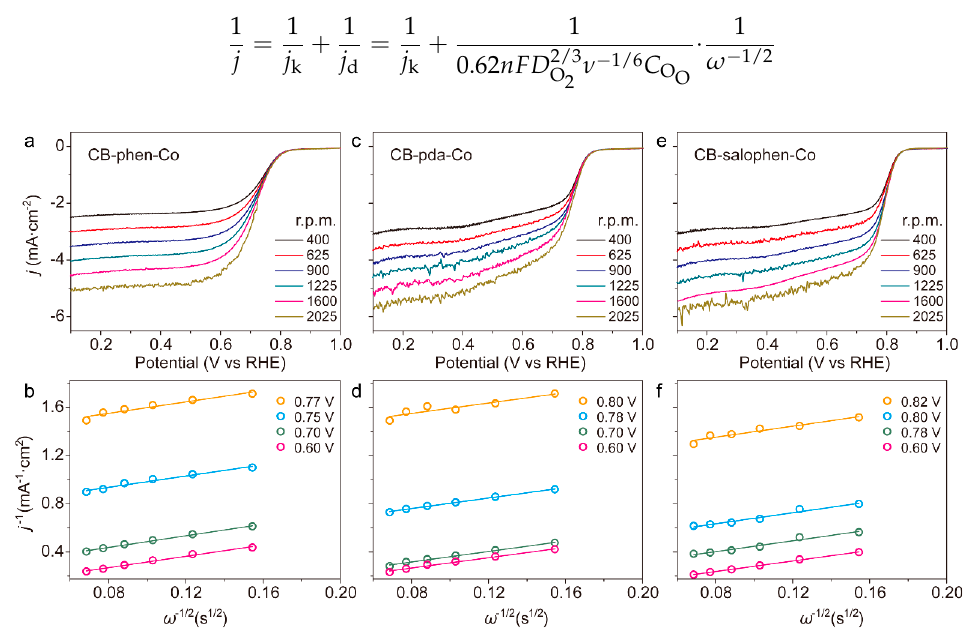
Figure 6. ORR performances of CB-conjugated complexes on RDE. Polarization curves ( a , c , e ) and Koutecky–Levich plots ( b , d , f ) of CB-phen-Co ( a , b ), CB-pda-Co ( c , d ) and CB-salophen-Co ( e , f ) in O 2 saturated electrolyte of 0.1 M KOH. The sweeping rate is 10 mV·s − 1 .